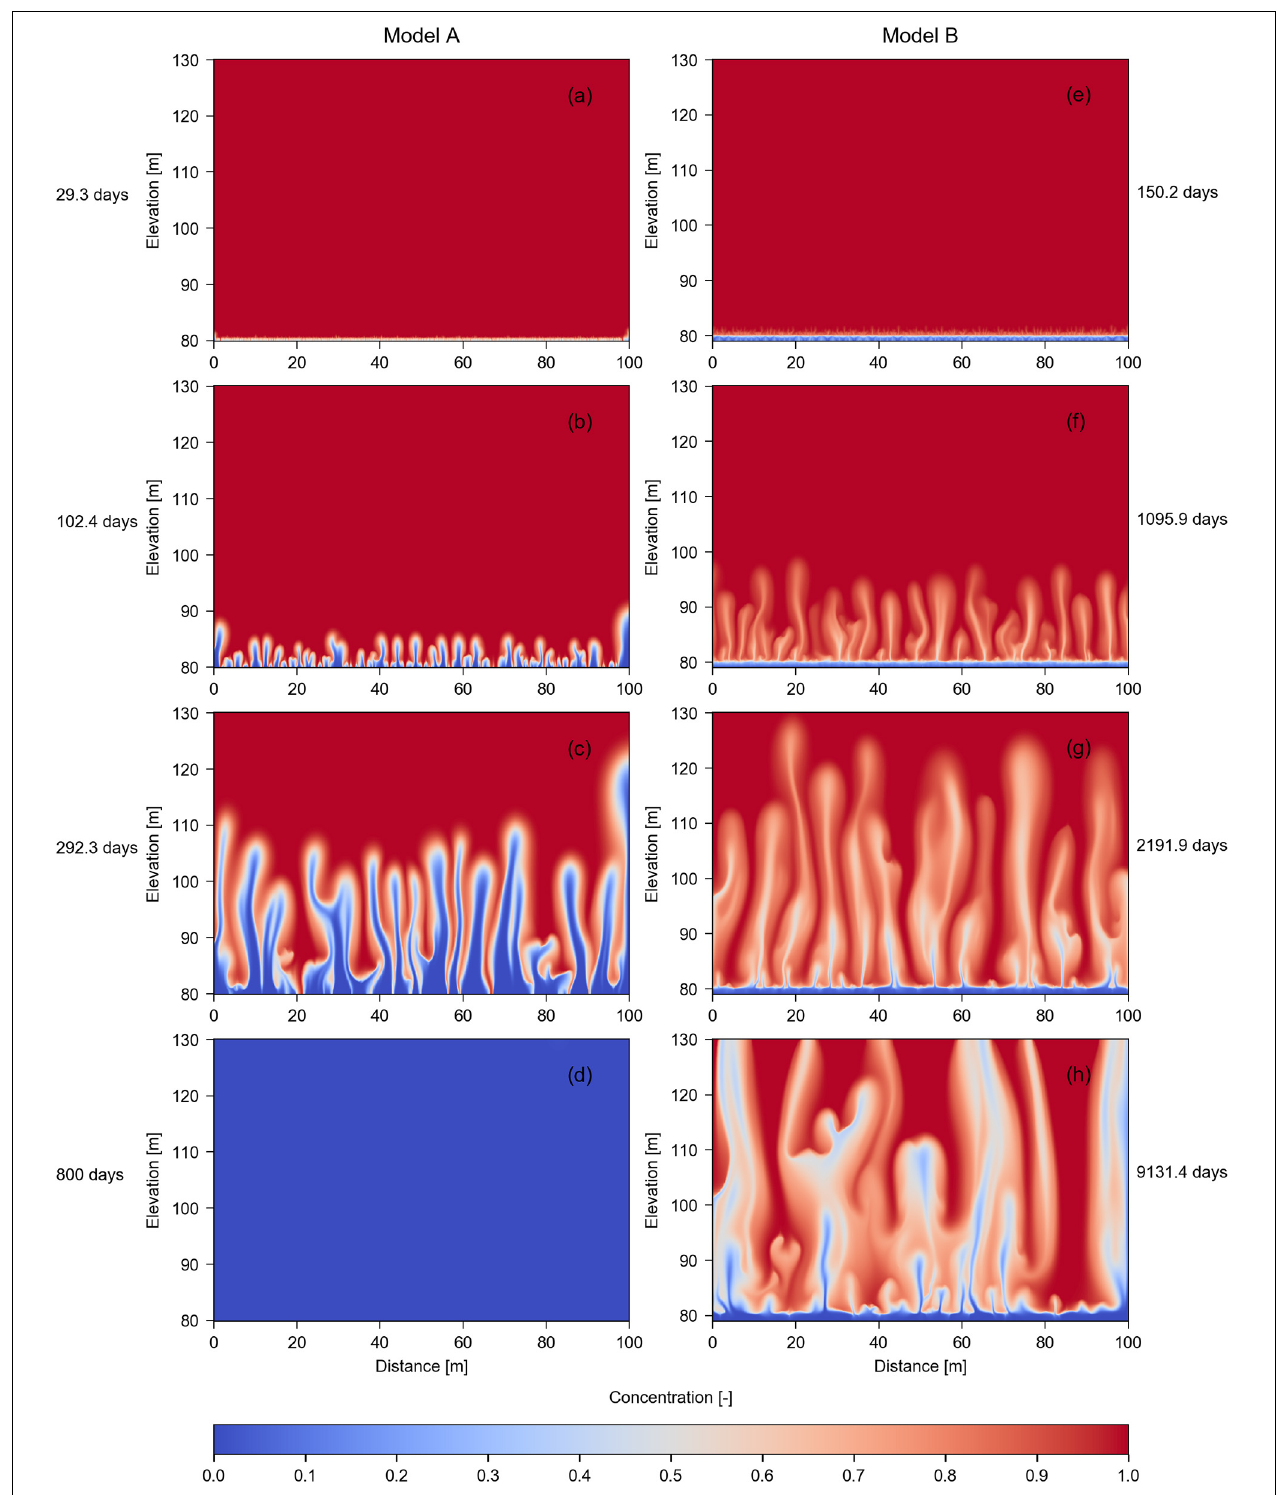
FIGURE 4 | Salinity distributions in seafloor sediments obtained from simulations of Case 1 (i.e., α L = 0.5 m; α T = 0.05 m) of Model A (left column) and Model B (right column) at various simulation times. Concentration values represent the relative seawater concentration, where 0 and 1 are freshwater and seawater, respectively. The bottom left subplot depicts steady-state results, while the bottom right subplot shows a quasi-steady state salinity distribution. (a) 29.3 days; (b) 102.4 days; (c) 292.3 days; (d) 800 days; (e) 150.2 days; (f) 1095.9 days; (g) 2191.9 days; (h) 9131.4 days.